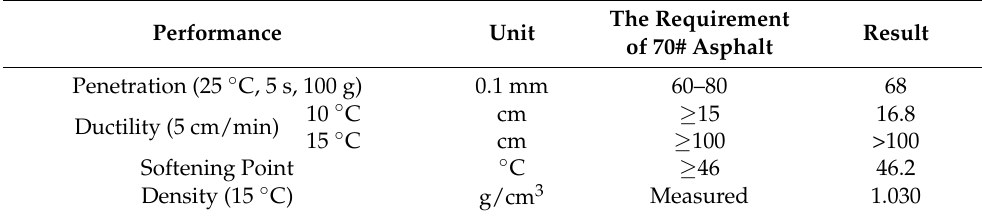
Table 2. Main technical indicators of E70# asphalt.